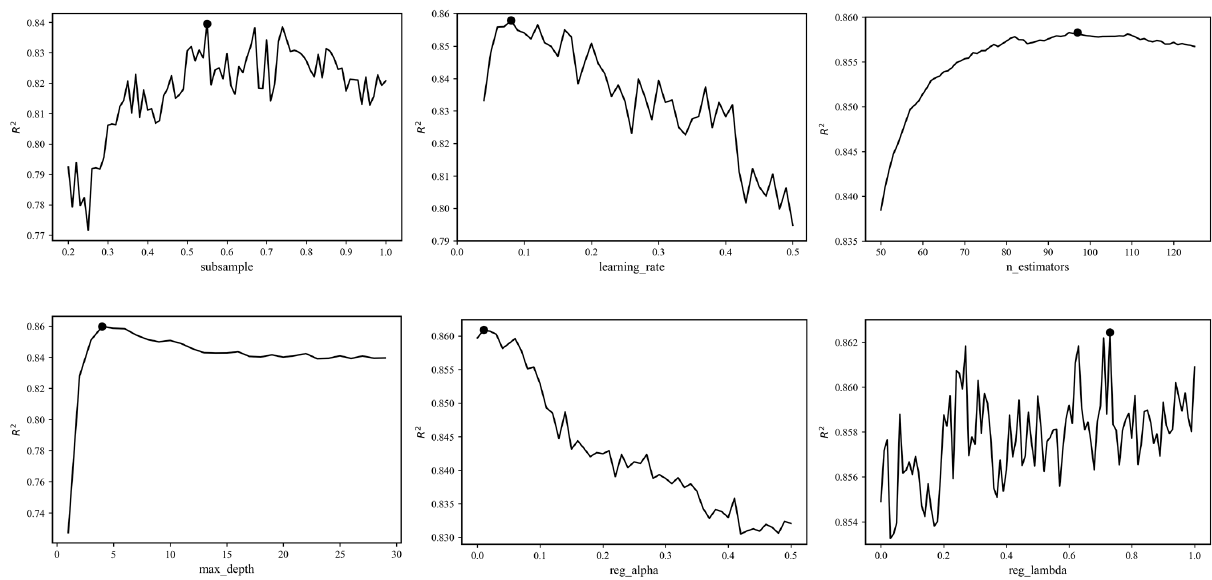
Figure 8. Determination of hyper-parameters for the XGBoost model.